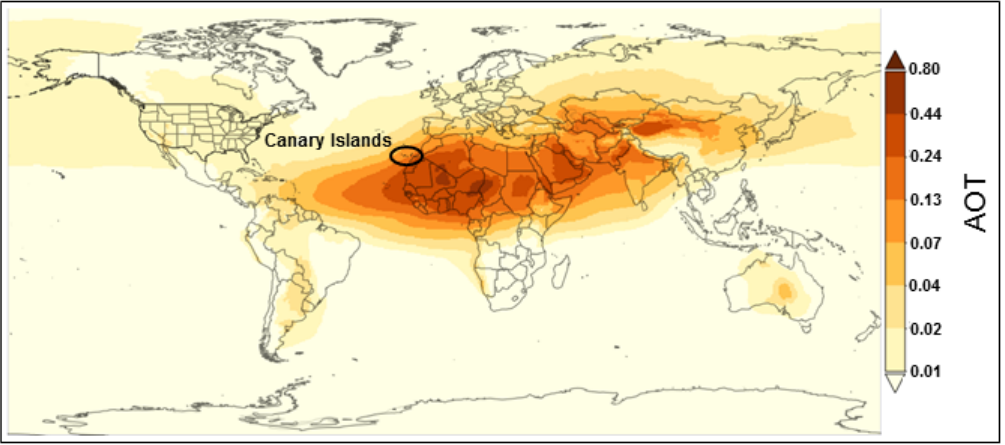
Figure 1. Annual mean distribution of dust extinction Aerosol Optical Thickness (AOT) in 2017, highlighting the location of the dust belt, the westward transport of dust to the Americas, and the location of Tenerife, Canary Islands: Data obtained from the Modern-Era Retrospective analysis for Research and Applications, Version 2